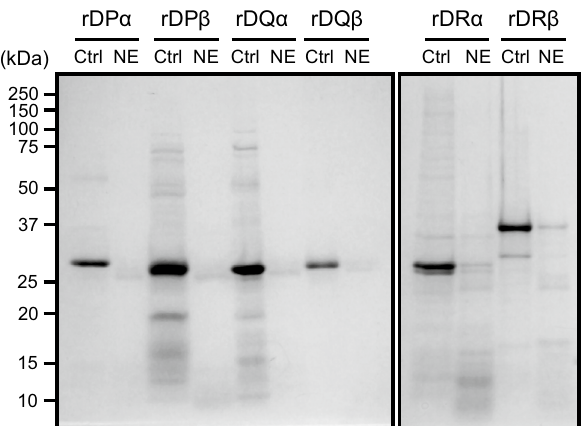
Figure 3. Neutrophil elastase (NE) degrades recombinant proteins which constitute HLA class II. Recombinant (r) HLA-DP α1, rHLA-DP β1, rHLA-DQ α1, rHLA-DQ β1, rHLA-DR α, and rHLA-DR β1 were treated with 300 mU/mL hNE at 37 °C for 3 h. All samples were separated by SDS-PAGE followed by Coomassie brilliant blue